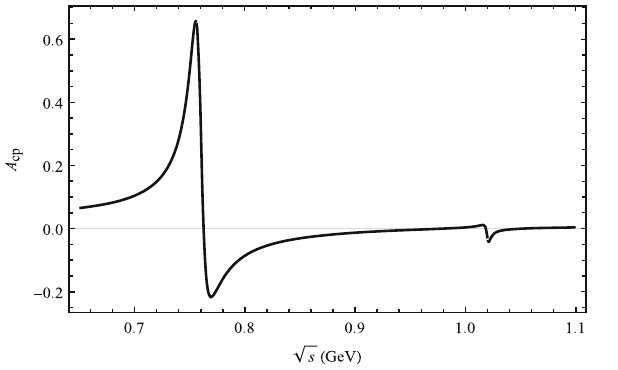
√ s corresponding to central